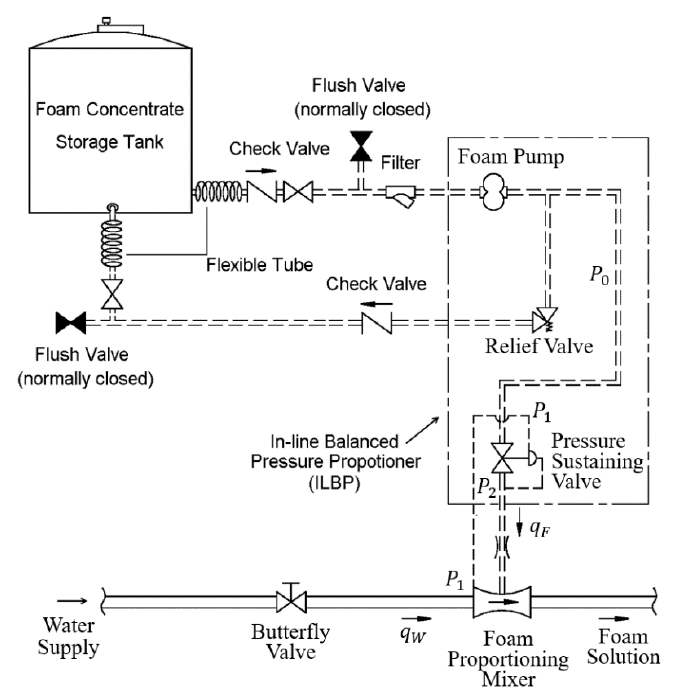
Figure 1. Schematic of the in-line balanced pressure (ILBP) proportioning system.